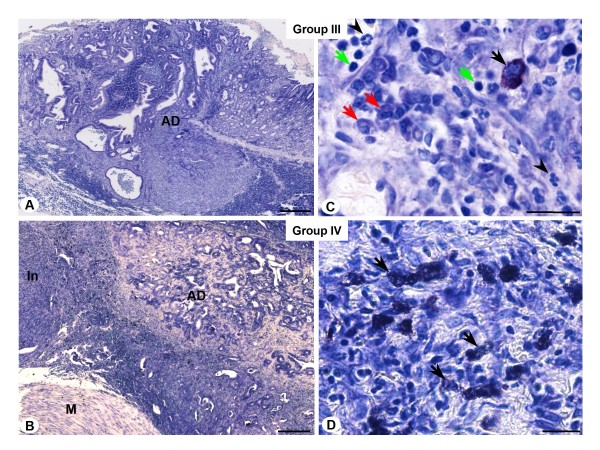
Histological analysis of adenocarcinoma induced by MNNG treatment. A and B) Morphological view of adenocarcinoma (AD) in non-denervated (group III) and denervated stomach (group IV). Muscular layer (M). Intense inflammatory infiltrate (In). C and D) Detail of inflammatory infiltrate of tumor stroma constituted by mast cells (black arrows), neutrophils (arrowheads), lymphocytes (green arrows) and plasma cells (red arrows). Toluidine Blue. Bars: 100 μm (Fig. A and B), 10 μm (Fig. C and D).